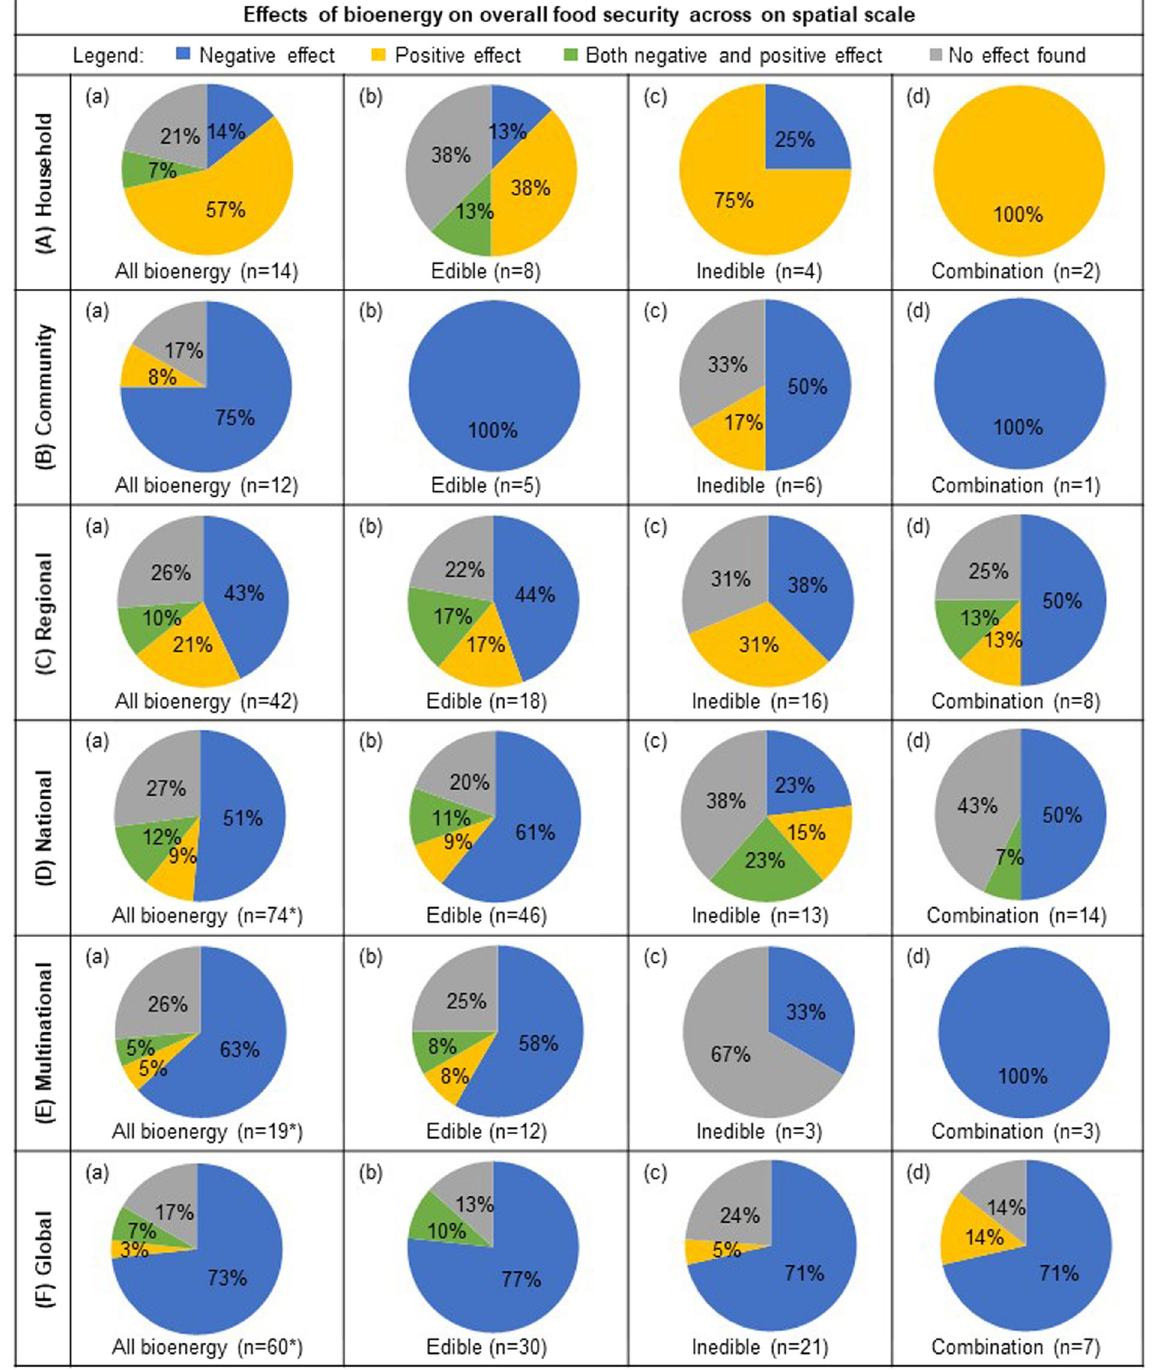
Fig. 5 Effects of bioenergy on overall food security across the spatial scale. Percentage of peer-reviewed publications ( n = 224) that reported either negative, positive, both negative and positive, or neutral effect of all bioenergy (column a ), edible ( b ), inedible ( c ), and studies that included a combination of both edible and inedible feedstocks in their analysis ( d ) at the household (row A ), community ( B ), regional ( C ), national ( D ), multinational ( E ), and global scales ( F ). *Bioenergy type “ not speci fi ed ” ( n = 4) is only included in “ All bioenergy ” (column a ), and therefore the sum of edible, inedible, and both edible and inedible feedstocks (columns b – d ) will not necessarily be a composite of “ All bioenergy ” . Studies with more than one spatial scale ( n = 3) are not may be due to higher prices faced by consumers and competition household scale demonstrates the local importance that bioe- of feedstocks with other food and feed crops. nergy feedstocks can play in diversifying the income of small- In addition, the evidence synthesized in this review suggests holder farmers and in providing them with a crop that provides a that the effects of bioenergy production on food security may relatively high price. In contrast to this positive local effect, the vary over time with accumulating negative effects; ~40% of the negative effects of bioenergy feedstock production at larger scales